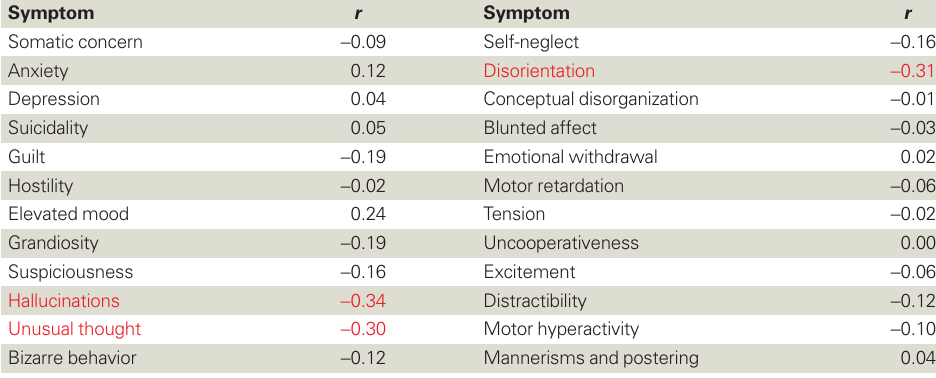
Table 2 | Correlation coefficients ( r ) for the correlations between single BPRS symptoms and dichotic listening laterality index. Symptoms and correlation coefficients that are marked in red showed significant correlations with the dichotic listening laterality index. Explanations of BPRS symptoms and formula for calculation of dichotic listening laterality index score are given based on correct reports for the right and left ear stimulus, respectively (see the text above). The three standard positive symptoms are ‘Hallucinations’, ‘Unusual Thought Content’, and ‘Bizarre Behavior’. The three standard negative symptoms are ‘Conceptual Disorganization’, ‘Blunted Affect’, and ‘Emotional